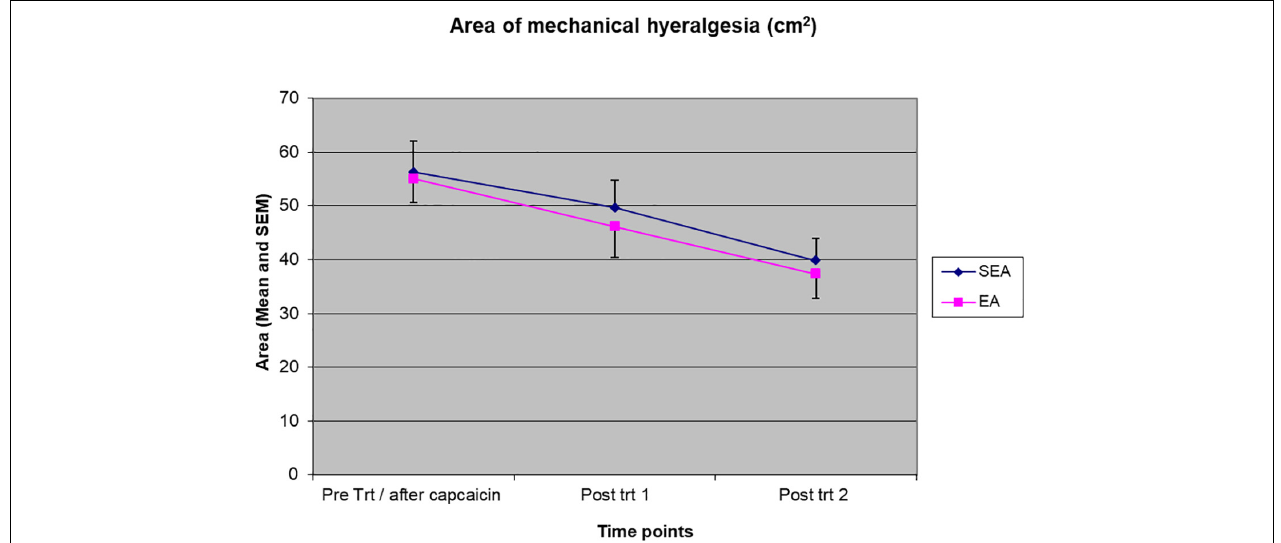
FIGURE 4 | The magnitude of the area of mechanical hyperalgesia before intervention/after capsaicin (Pre trt/after capsaicin), immediately after (Post trt 1) and 90 min after (Post trt 2) intervention in REA and SEA groups. Data are expressed as mean ± SEM.